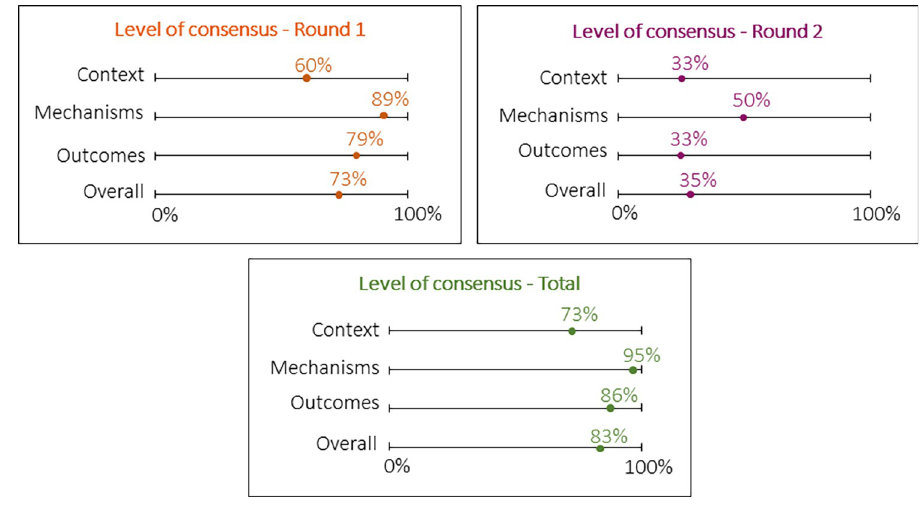
Fig 3. Level of consensus found in round 1 and